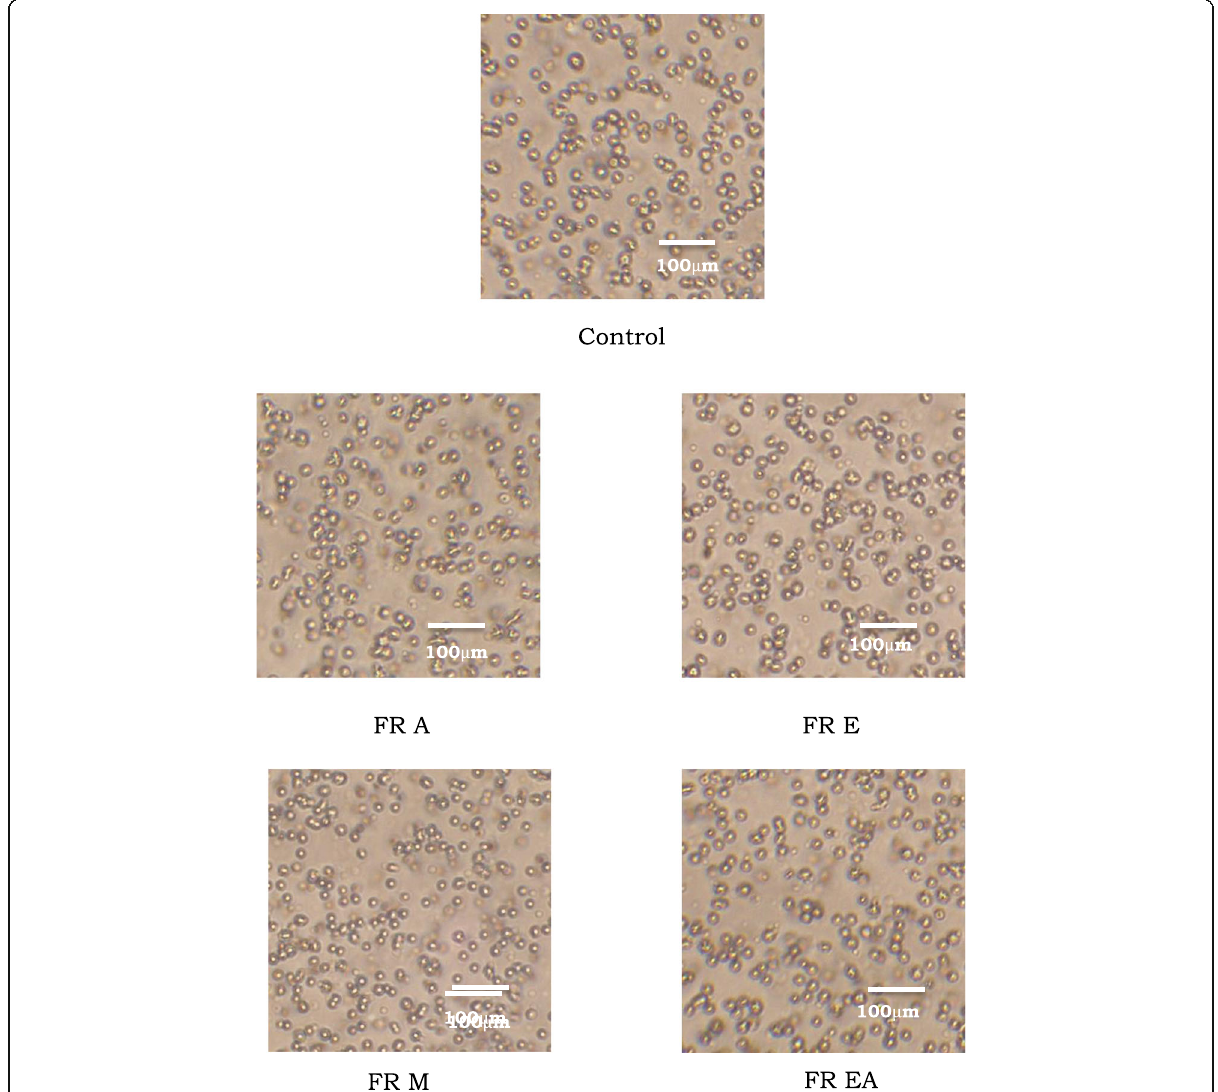
Fig. 8 Morphological changes observed in lymphocytes when treated with F. religiosa latex extracts (200 μ g/ml) along with control (lymphocytes). A — acetone; E — ethanol; M — methanol; EA — ethyl